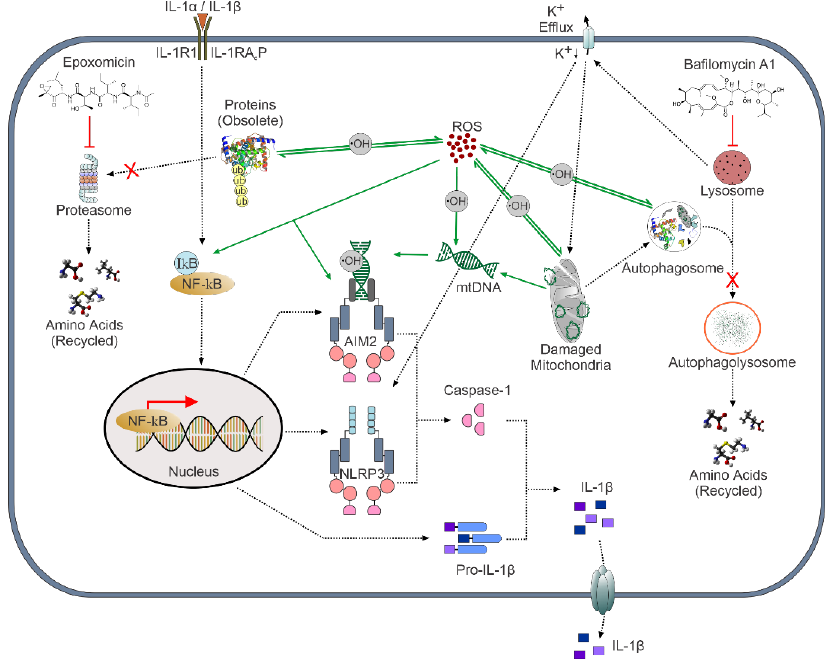
Figure 9. Epoxomicin-induced proteasome inhibition led to mitochondrial damage and ROS production, followed by activation of the predominant inflammasome AIM2 and, to a lesser degree, that of inflammasome NLRP3.